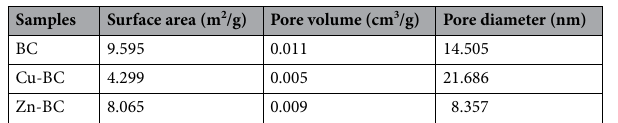
Table 8. Parameters of specific surface area and pore structure for BC, Cu-BC and Zn-BC.